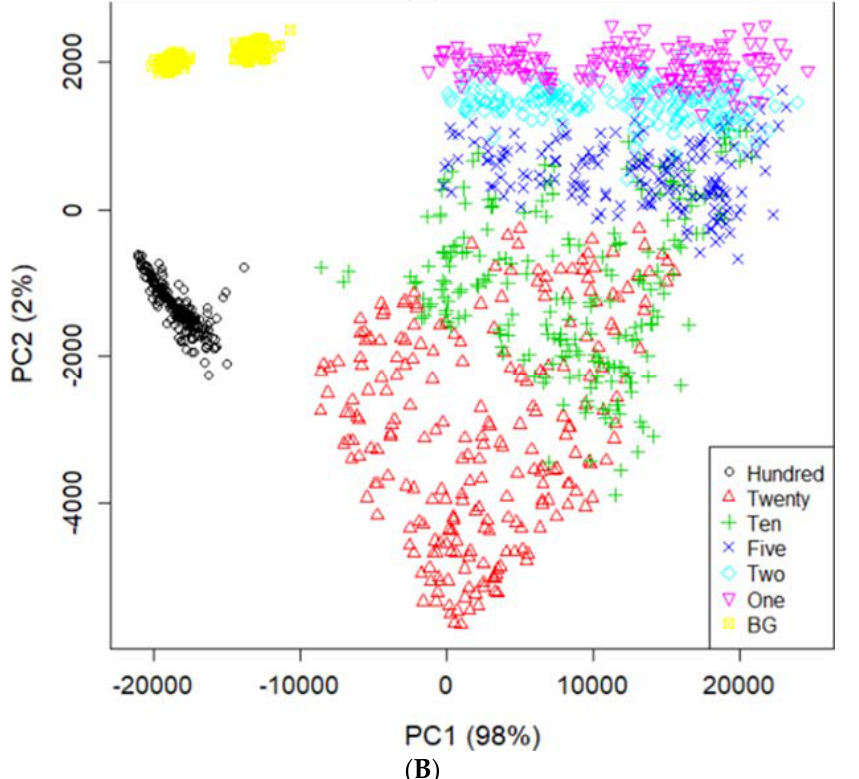
Figure 5. PCA image on PC1 and PC2 space using the spectral data of potato ( A ) and spinach ( B ) from the residues and background ROI.